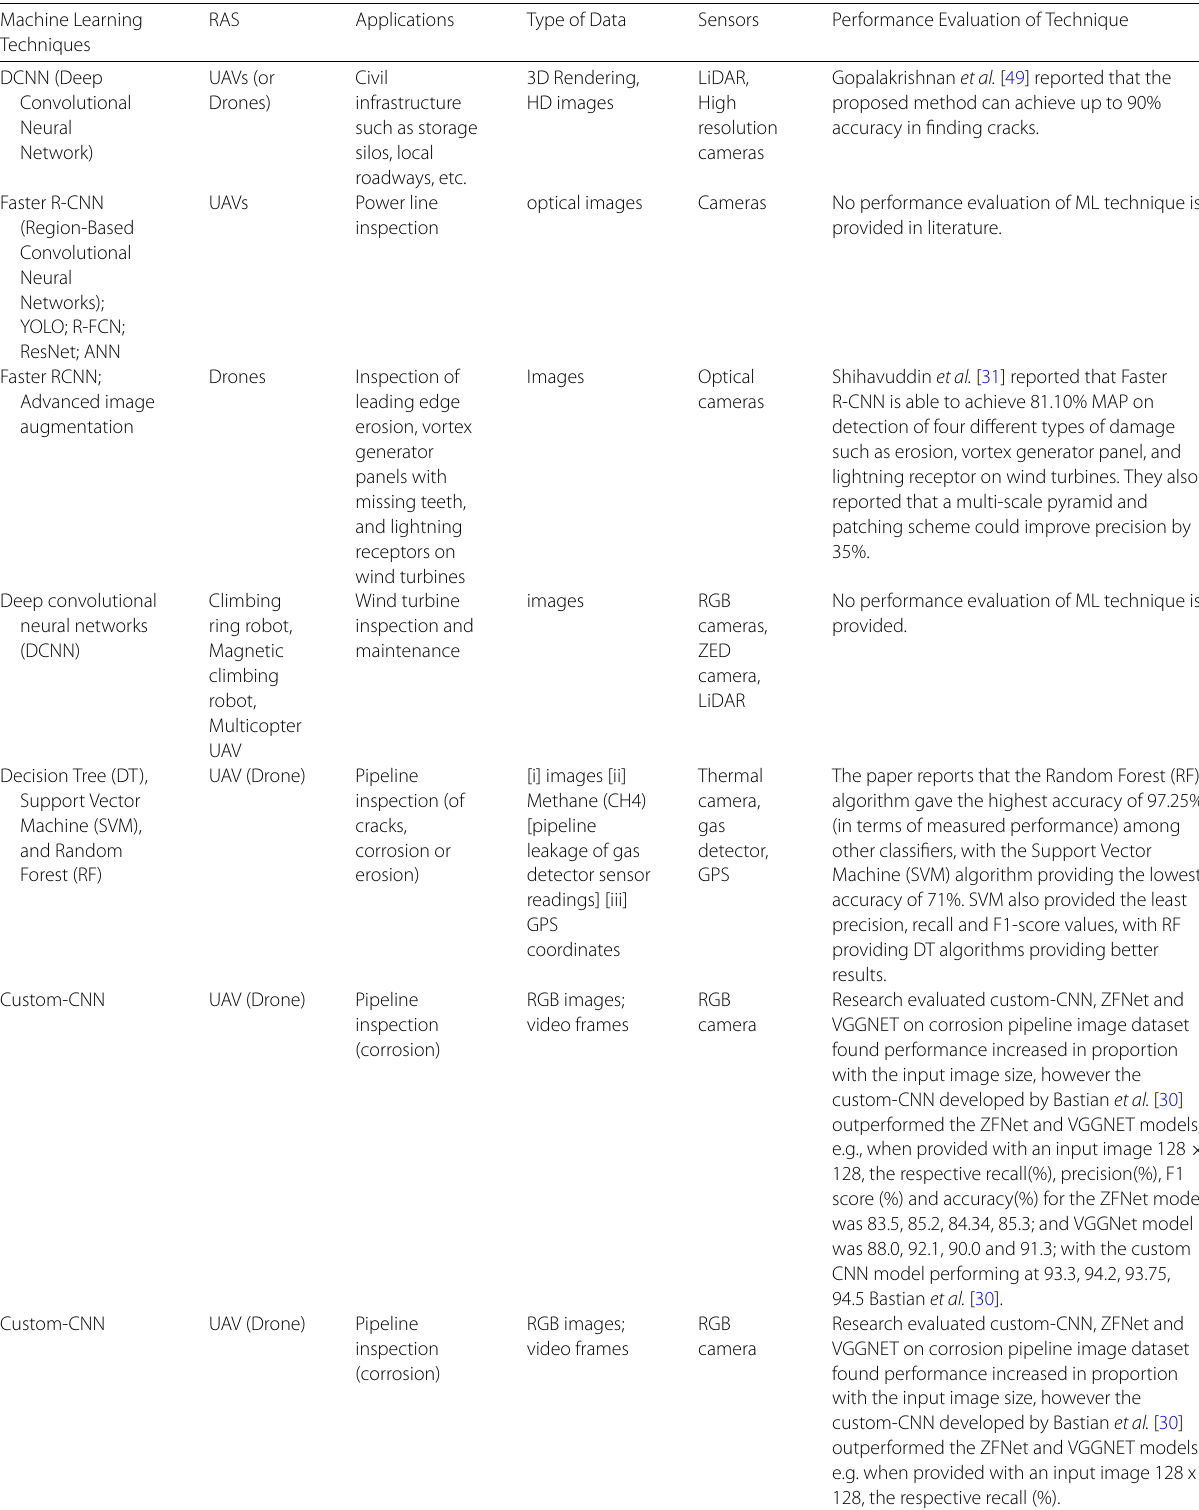
Table 3 Evaluation of Machine Learning techniques used for RAS-based inspection Machine Learning